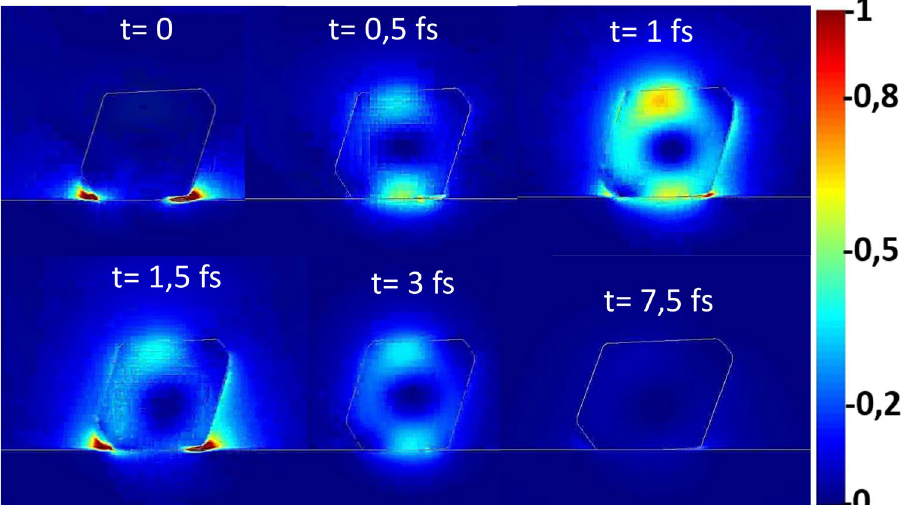
Figure 5. Normalised electric field intensity on colour scale inside the Si-NP exposing [111] facet after irradiation with 532 nm laser attesting the light trapping at the base of the Raman signal